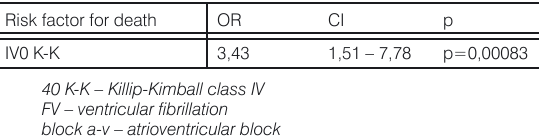
Table 6. Risk factors for death – multivariate